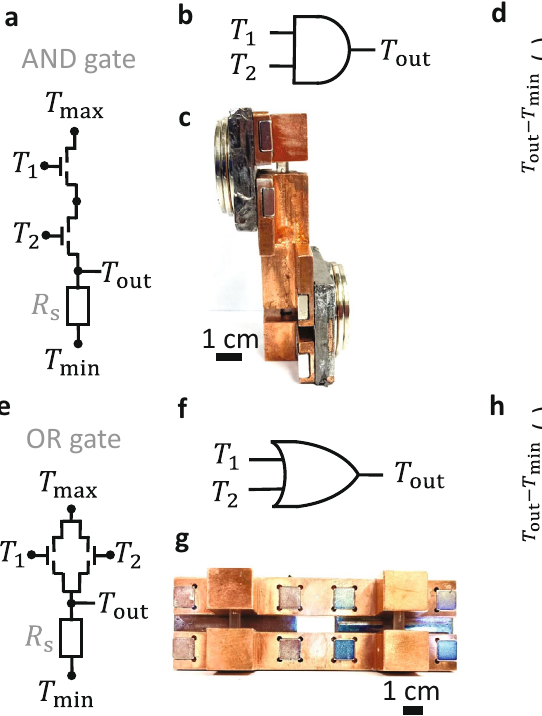
temperatureforthefourcasesisaBoolean1(HIGH)onlyif T 1 and T 2 arebothlarger than T off (cid:3) on , while the output temperature is a Boolean 0 (LOW) otherwise. e Thermalcircuitschematic, f logicgaterepresentationand g imageofthermalOR gate consisting of two transistors thermally in parallel. h The measured OR gate truth tableshowing thatthe thermal output is HIGH if either T 1 or T 2 islarger than T off (cid:3) on and LOW